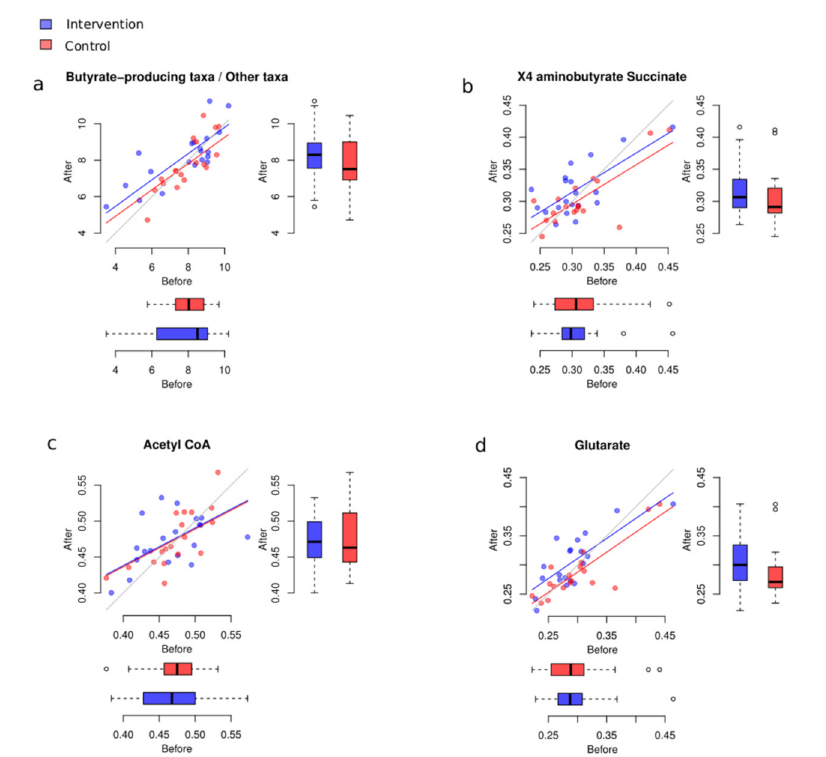
Figure 7. Changes to taxa with butyrate-production potential. ( a ) Changes of balance between main butyrate-producing taxa and all other bacteria in the intervention and control groups. ( b – d ) Butyrate synthesis pathways before and after the intervention in two